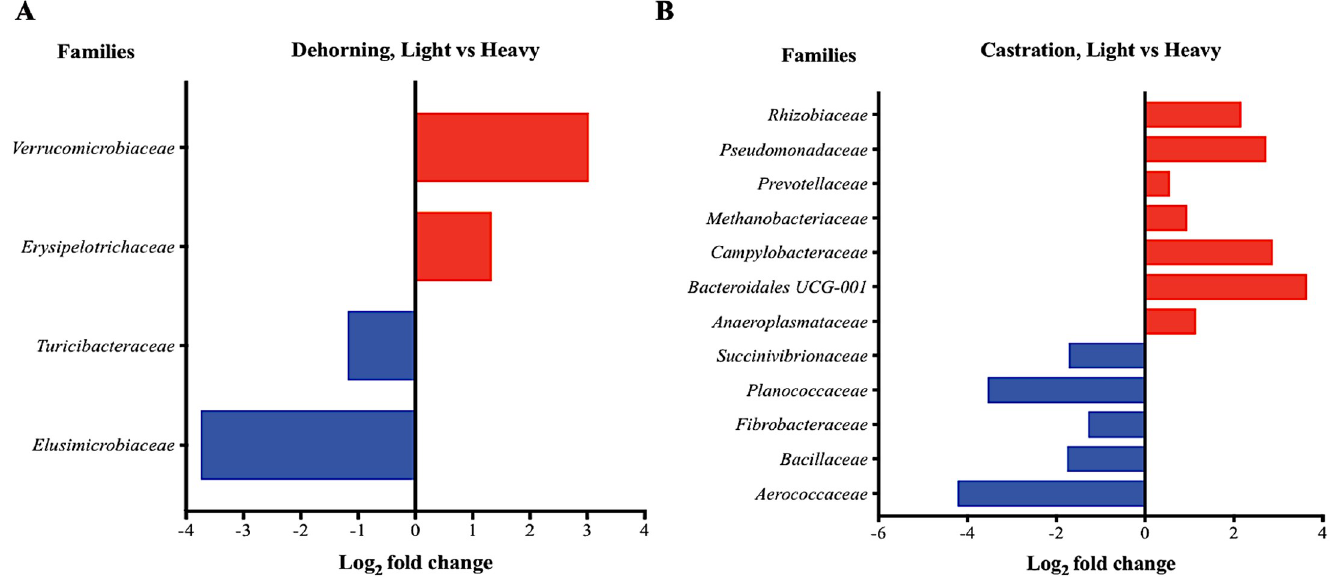
Fig 3. Differential abundance analysis of OTUs (family-level) between heavy- and light-weight calves after dehorning (A) and castration (B). OTU tables were rarefied to the sample containing the lowest number of sequences in each analysis. OTUs were assigned at the family level, and families with relative abundance of more than 0.1% of the total were used in DAA analysis. For multiple comparisons an estimate of the FDR was calculated to determine differentially abundant families with a significance threshold of p -value < 0.05. The families represented by the red bars are relatively more abundant in the light-weight calves; the families represented by the blue bars are relatively more abundant in the heavy-weight calves at Day 3 after dehorning (A) and castration (B).